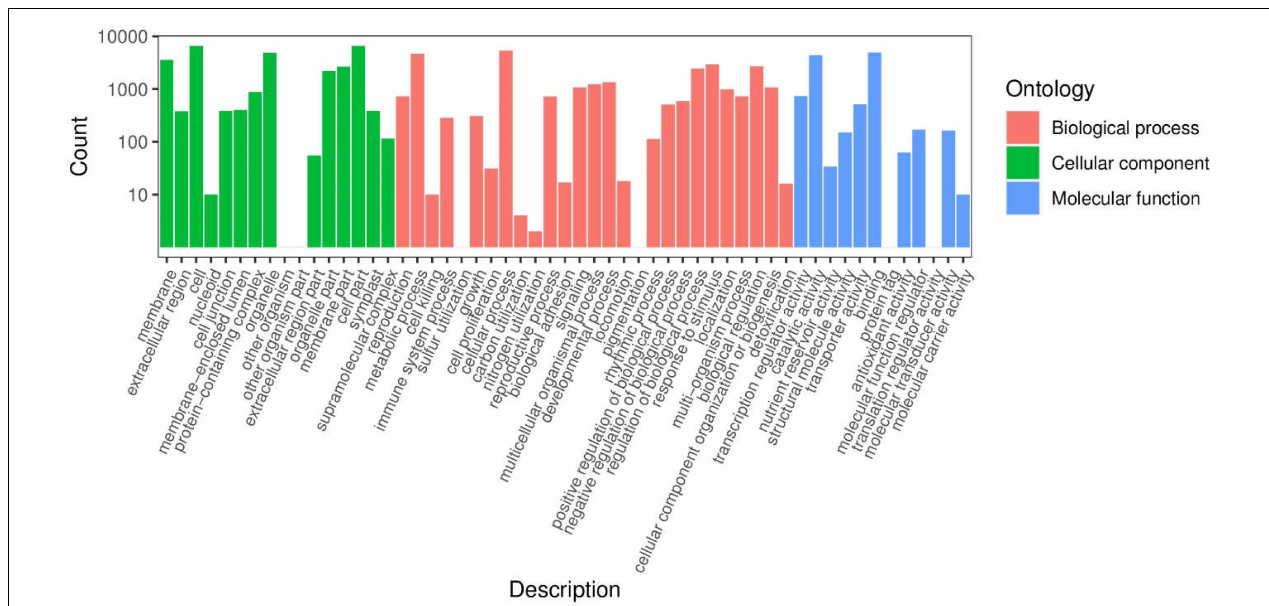
FIGURE 11 | Classification of secondary entries of Qssg and Lc fruit difference